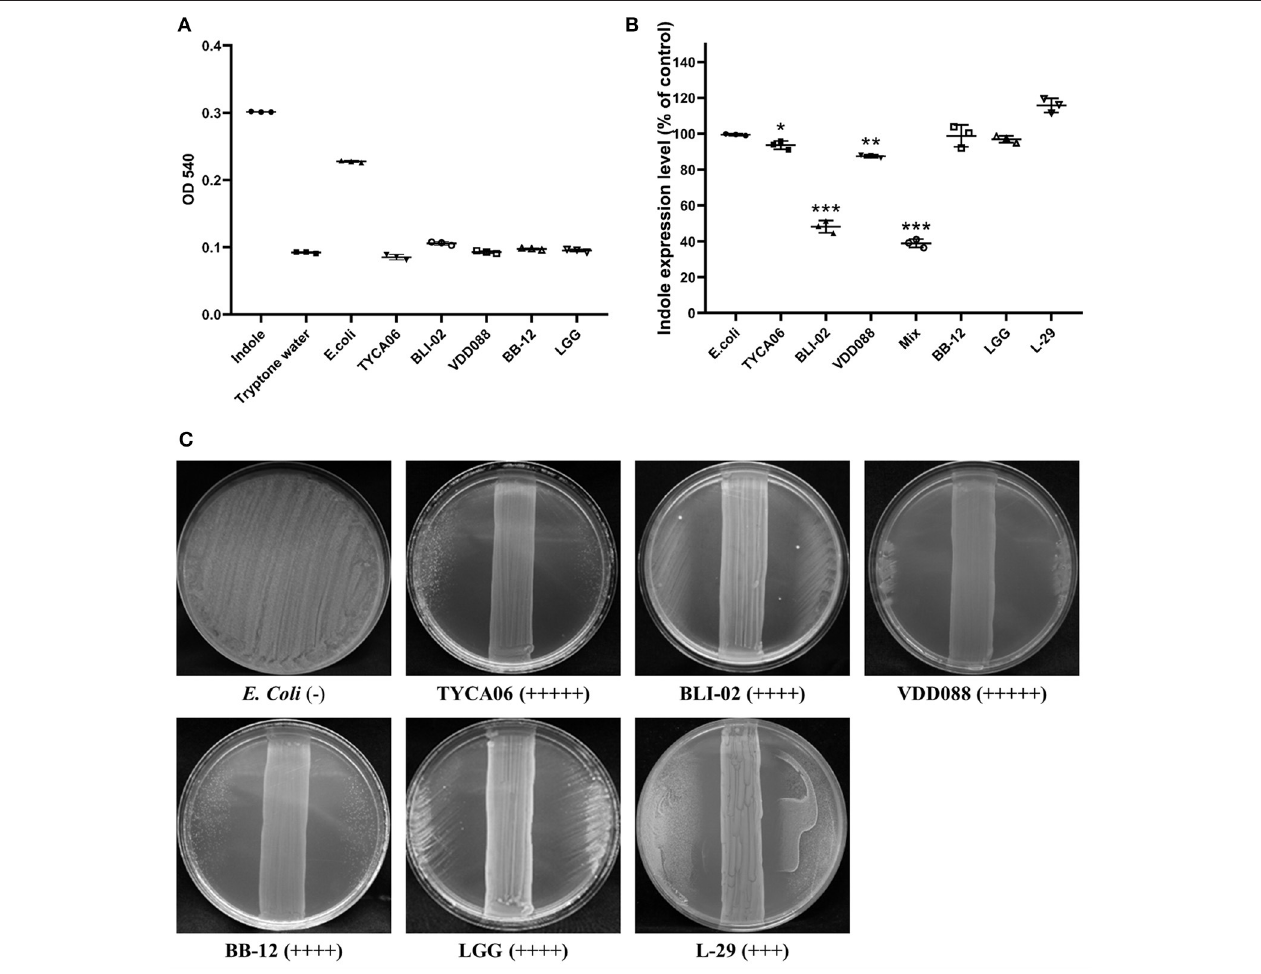
FIGURE 1 | Effect of different probiotic strains on indole production. (A) The indole levels produced by individual probiotic strains were measured. Indole (1mM) was added as a positive control, while tryptone water was added as a negative control. (B) Indole levels in co-cultures of E. coli and probiotics. The E. coli group was regarded as a control. Other bacterial groups [ Lactobacillus acidophilus (TYCA06) , Bifidobacterium longum subspecies infantis (BLI-02), Bifidobacterium bifidum (VDD088), Bifidobacterium animalis subspecies lactis (BB-12), L. rhamnosus GG (LGG), and L. plantarum (L-29)] were co-cultured with E. coli . The mixed group indicates the co-cultures of Lactobacillus acidophilus (TYCA06), Bifidobacterium longum subspecies infantis (BLI-02), Bifidobacterium bifidum (VDD088), and E. coli . * P < 0.05, ** P < 0.01, *** P < 0.001, as compared with the E. coli group. (C) Antimicrobial ability of different probiotic strains. (–), no detectable zone of inhibition for E. coli ; ( +++ ), 3–4cm inhibition; ( ++++ ), 4–5cm inhibition; ( +++++ ), 5–8.5cm inhibition. Different probiotic strains included Lactobacillus acidophilus TYCA06 (TYCA06), Bifidobacterium longum subspecies infantis BLI-02 (BLI-02), Bifidobacterium bifidum VDD088 (VDD088), Bifidobacterium animalis subspecies lactis BB-12 (BB-12), L. rhamnosus GG (LGG), and L. plantarum L-29